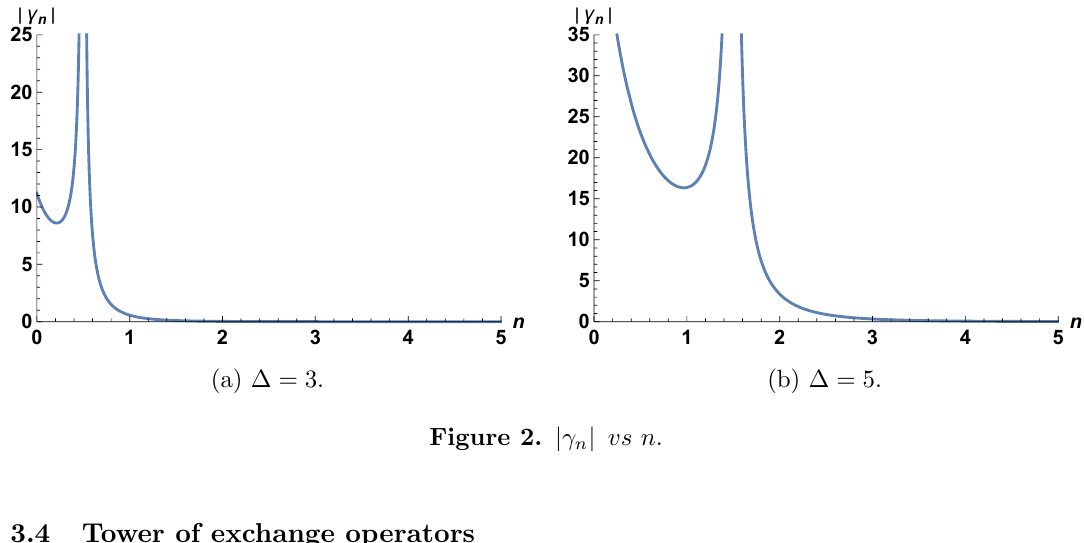
Figure 2. j (cid:13) n j vs n